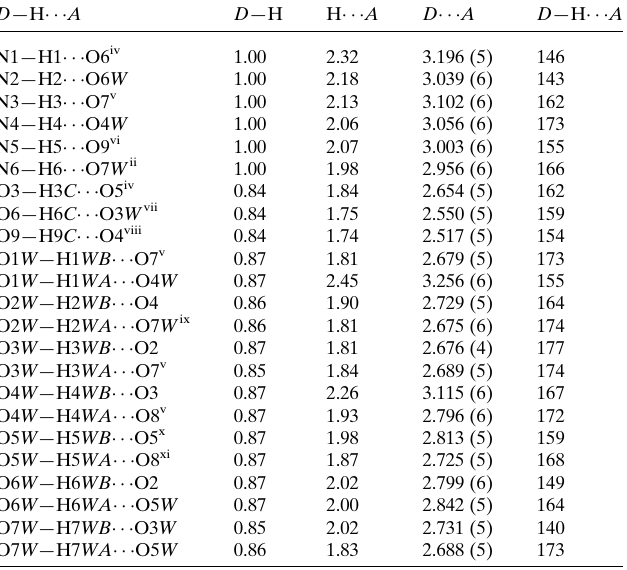
Table 2 Hydrogen-bond geometry (A˚ , (cid:4) ).